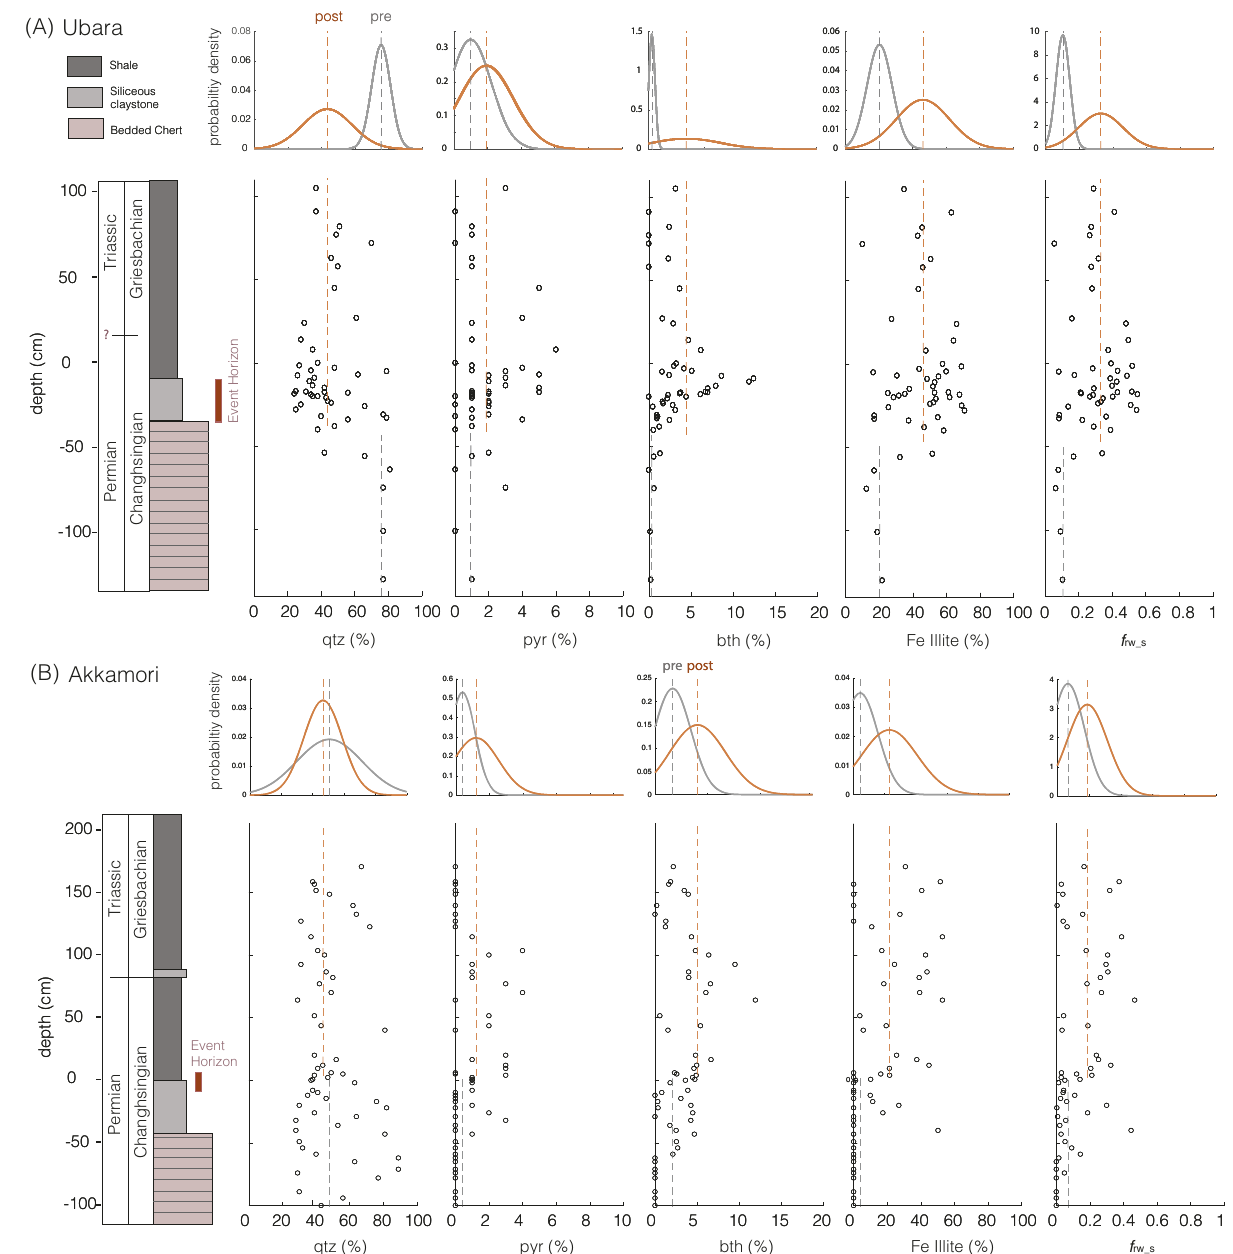
Fig. 5 Mineralogical data across the extinction event. Mineralogical data from ( A ) Ubara and ( B ) Akkamori. Quartz (qtz); pyrite (pyr); berthierine (bth); Fe-illite; and f rw_s